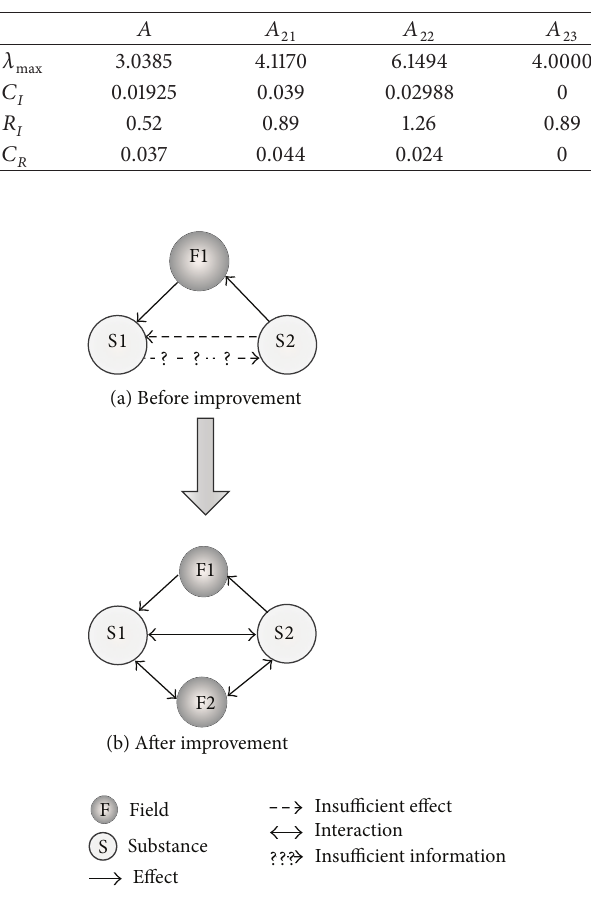
Figure 7: Substance-field model of steering